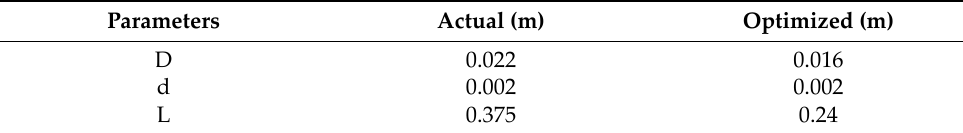
Table 5. Experimental dimensions of actual and optimized tub size.